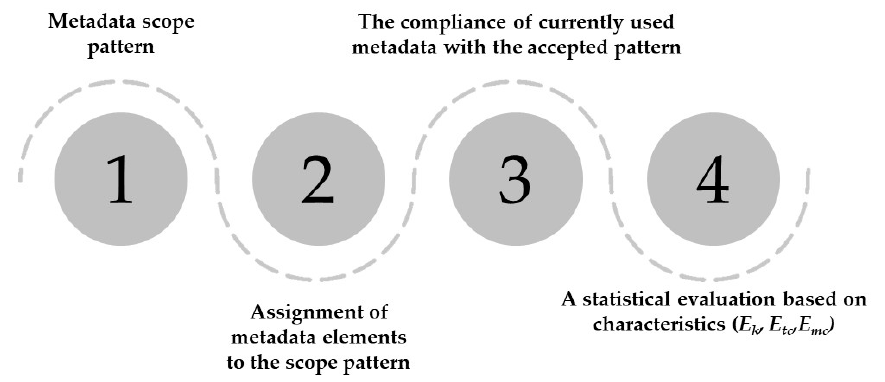
Figure 2. Workflow of metadata evaluation.